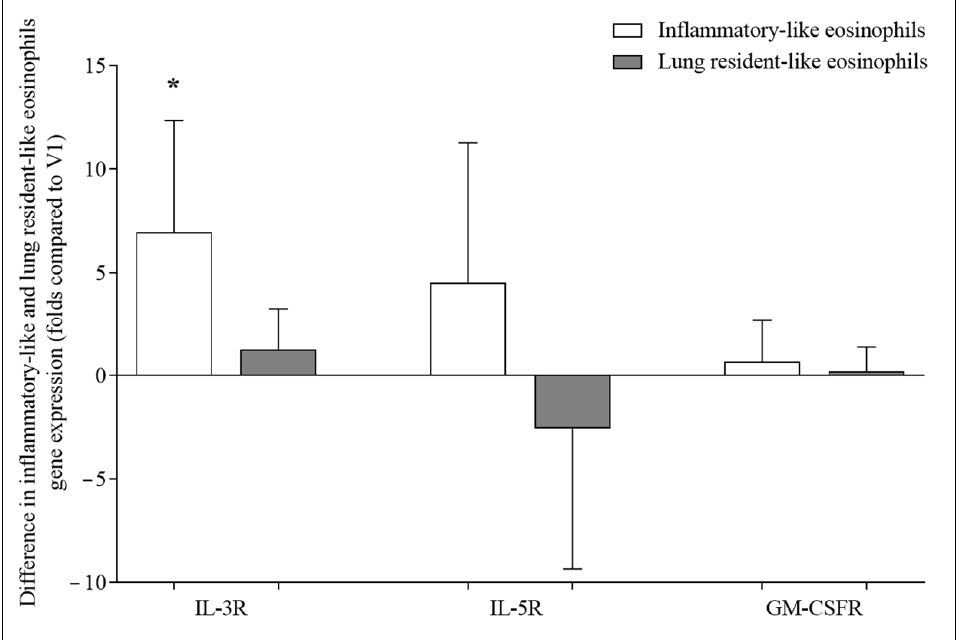
Figure 6. Differences in the expression of IL-3R, IL-5R, and GM-CSFR genes before and after bronchial allergen challenge. V2, visit 2 (24 h after bronchial allergen challenge). IL-3R—interleukin 3 receptor; IL-5R—interleukin 5 receptor; GM-CSFR—granulocyte-macrophage colony-stimulating factor receptor. Results from independent experiments of AA, n = 8. Data presented as the mean ± standard error of the mean, fold change over expression of IL-3R, IL-5R, and GM-CSFR gene after bronchial allergen challenge. * p < 0.05 compared with V2. Statistical analysis: between investigated groups, Mann–Whitney two-sided U-test; within one study group, Wilcoxon matched-pair signed- rank two-sided test. Data presented as the mean ± standard error of the mean.